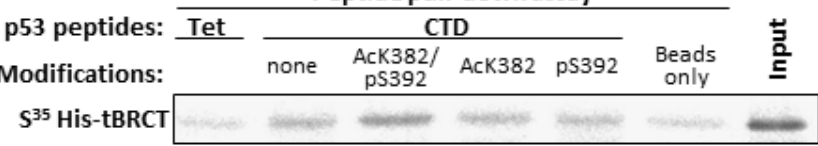
Figure 3. The CTD of p53 interacts with MDC1-tBRCT and this interaction is modulated by acetylation of K382 and phosphorylation of S392 in p53. . Peptide pull-down assay was performed with peptides corresponding to the CTD of p53 (a.a 361-393) that were either without PTMs (none), acetylated on K382 (AcK382), phosphorylated on S392 (pS392) or containing both PTMs, or with a peptide corresponding to the Tet domain of p53 in the presence of radio-labeled His-tBRCT. Bound proteins were visualized using autoradiography. doi: